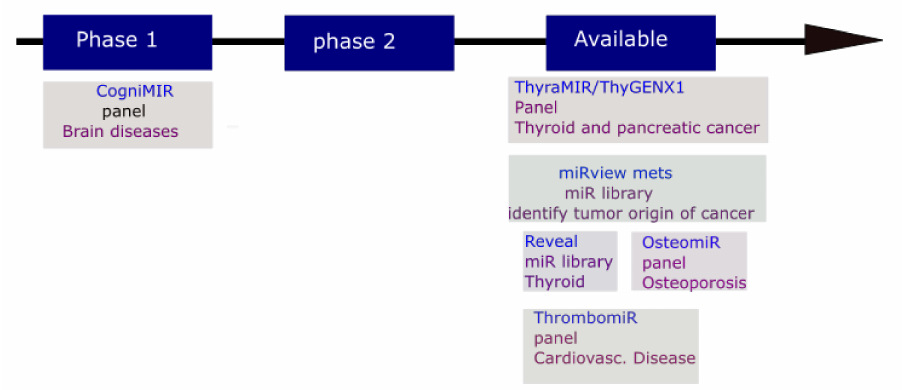
Figure 3. miRNA-based diagnostic tools available in